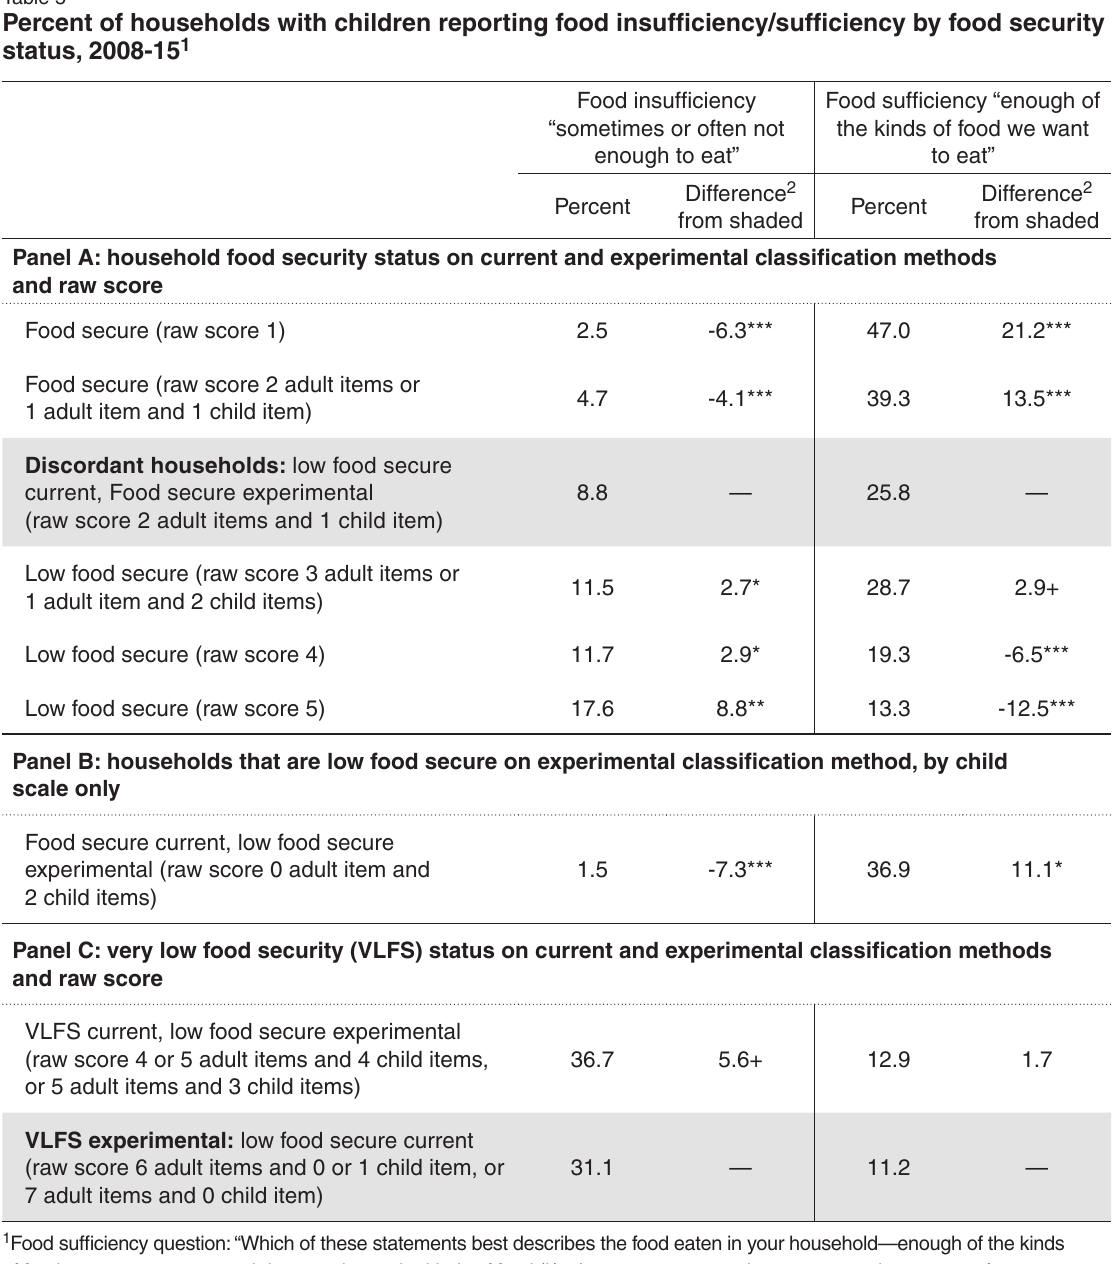
Percent of households with children reporting food insufficiency/sufficiency by food security status, 2008-15 1